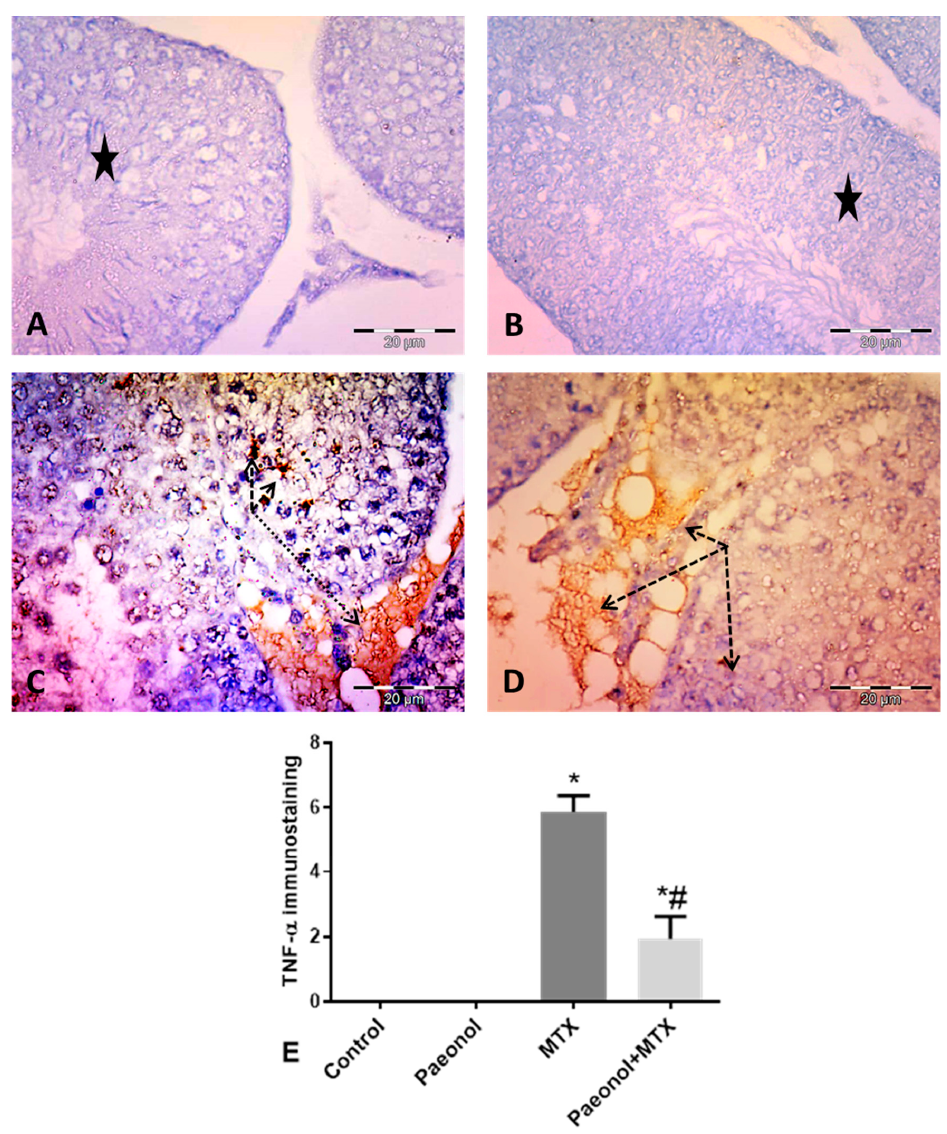
Figure 2. Immunohistochemical expression of testicular tumor necrosis factor-alpha (TNF- α ) (×400). ( A and B ) Control and paeonol groups respectively, showing negative TNF- α immunoreactivity (stars) in the germinal cells. ( C ) MTX group showing cytoplasmic TNF- α immunoreactivity in the germinal cells and in the interstitial cells (dashed arrows). ( D ) Paeonol + MTX group showing faint cytoplasmic TNF- α expression in the germinal and interstitial cells (dashed arrows). ( E ) Mean area fraction of TNF- α immunostaining. Results are mean ± SEM ( n = 8). * ,# Significantly different ( p < 0.05) from control and MTX groups, respectively. MTX: methotrexate.